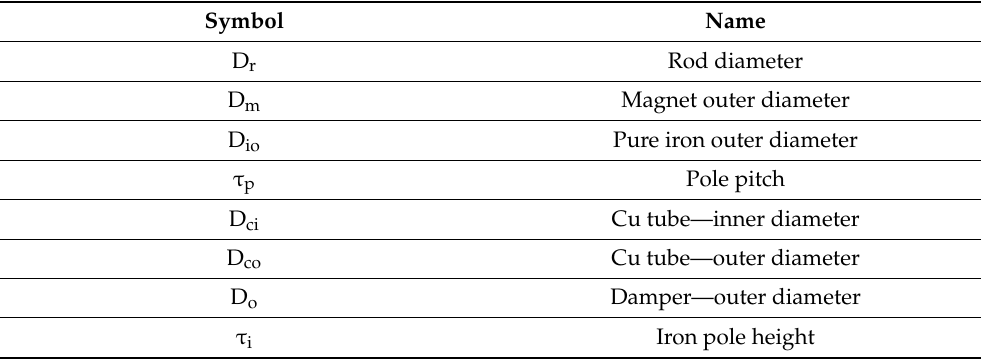
Figure 1. Schematics of the EC damper (cross section view). Table 1. Main parts and parameters of the EC damper.